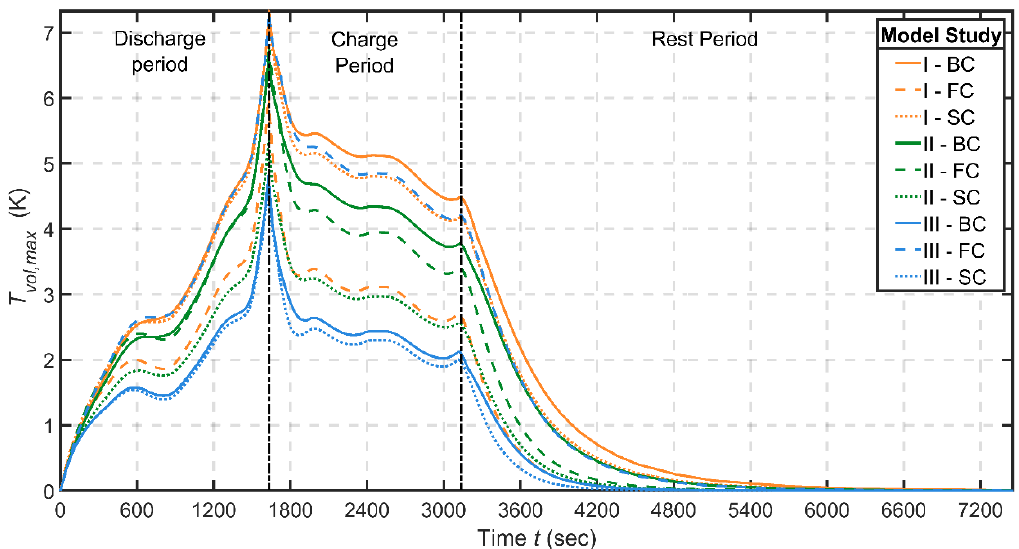
Figure 10. Simulated maximal temperature rise T { vol , max } in dependence of the cell design and the cooling types BC, SC and FC during a 2 C cycle and 1 hour rest time.